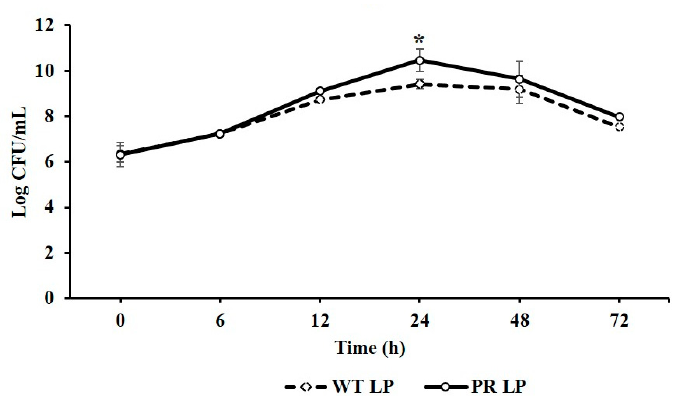
Figure 1. Growth pattern of wild-type Lactobacillus plantarum (LP) and phage-resistant Lactobacillus plantarum (LP + PR ) strains at 0, 6, 12, 24, 48, and 72 h. Error bars indicate standard deviation from 6 parallel trials. Asterisks indicate the significant growth when compared to wild-type LP strain at P <